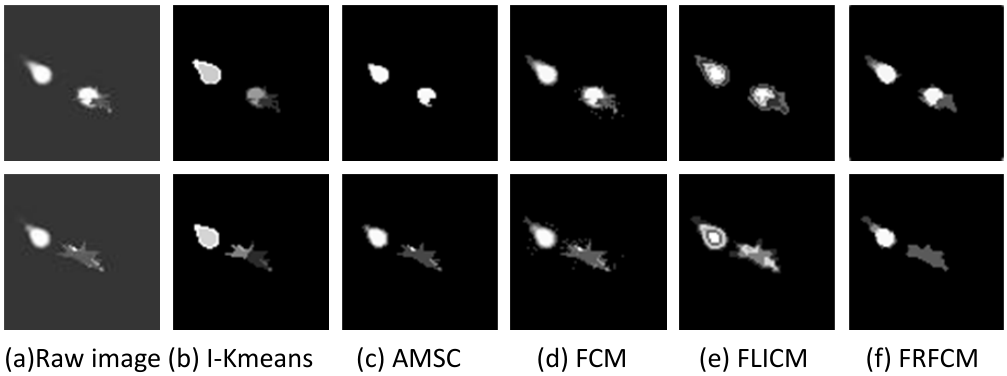
Figure 6. Comparison of different clustering algorithms.